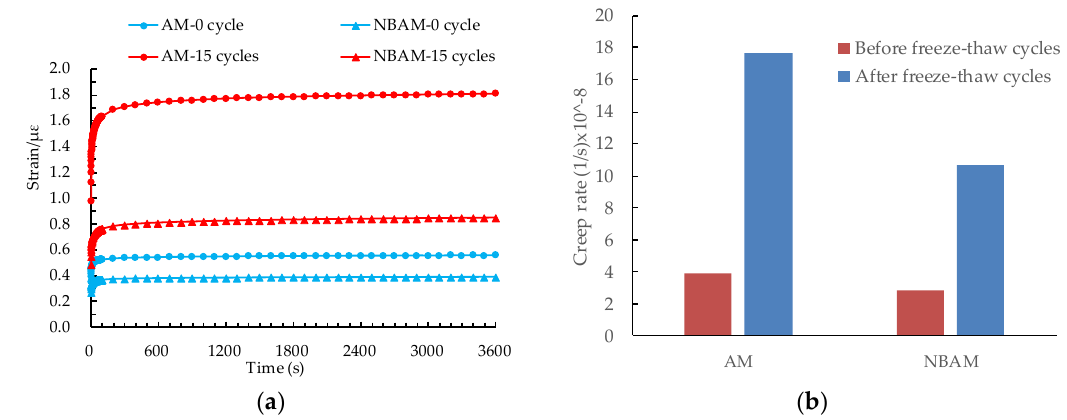
Figure 11. Static creep: ( a ) relationship between static creep time and strain; ( b ) the change of creep rate.